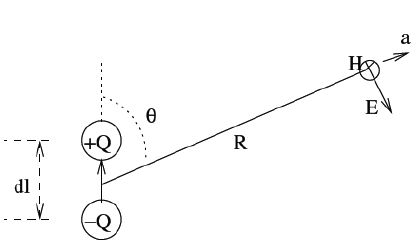
Figure 9. A Hertzian Dipole.